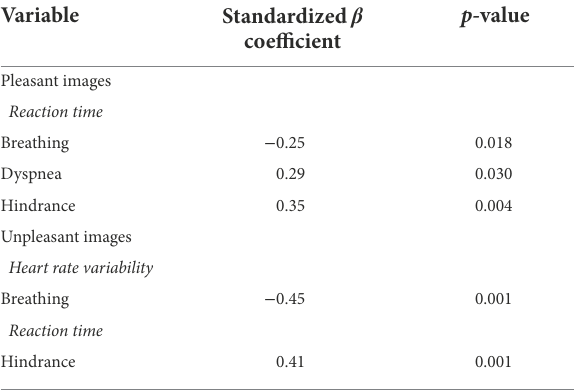
TABLE 4 Hierarchical Regression Model Predictors of Performance Under Emotional